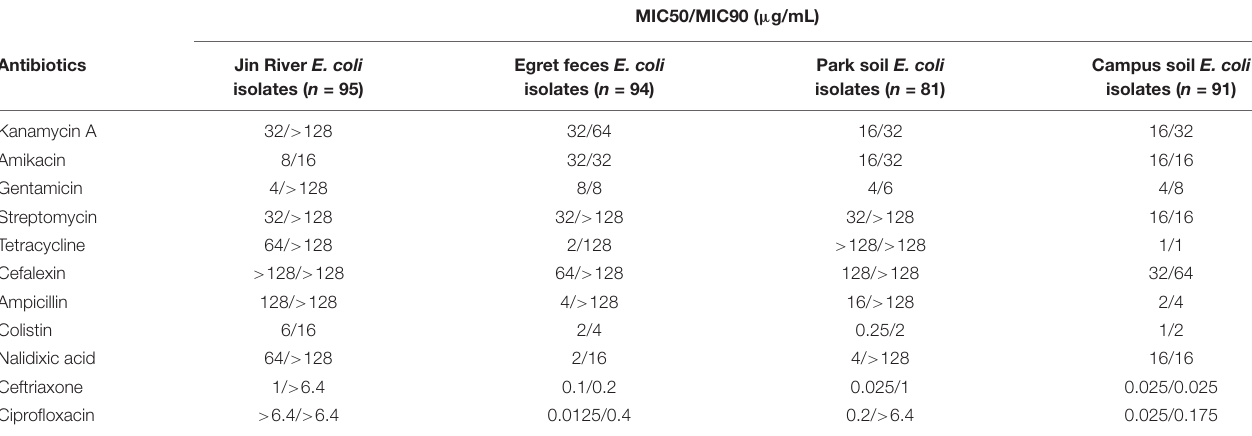
TABLE 1 | MIC50 and MIC90 of different antibiotics against the E. coli strains isolated from different environmental